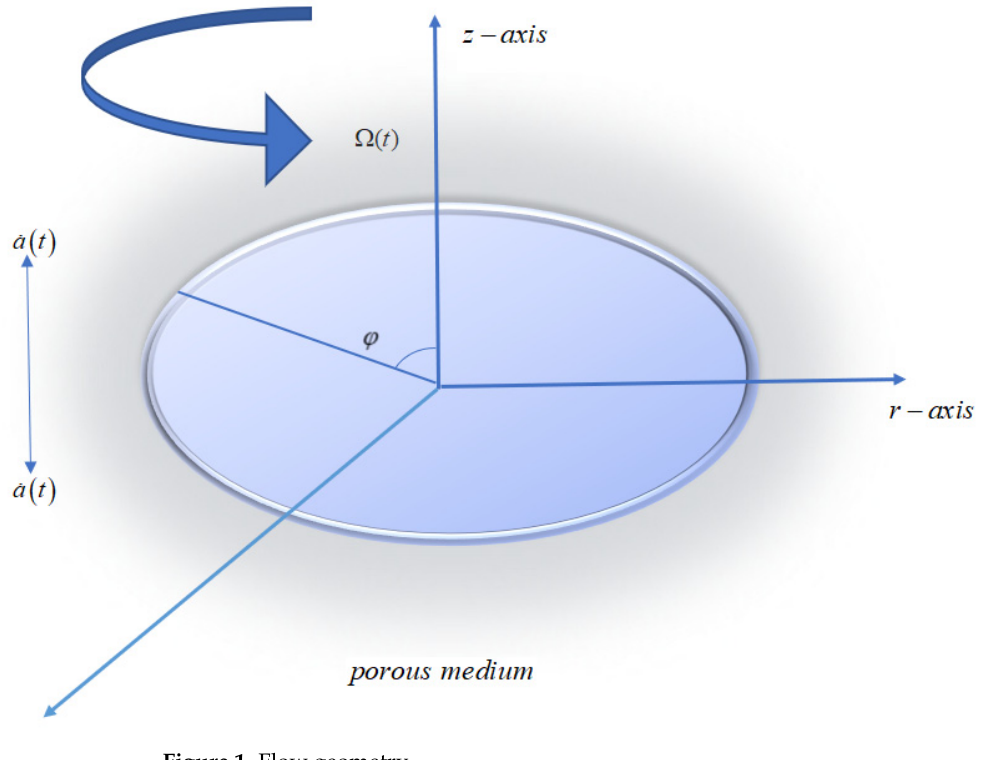
Figure 1. Flow Figure 1. Flow geometry.